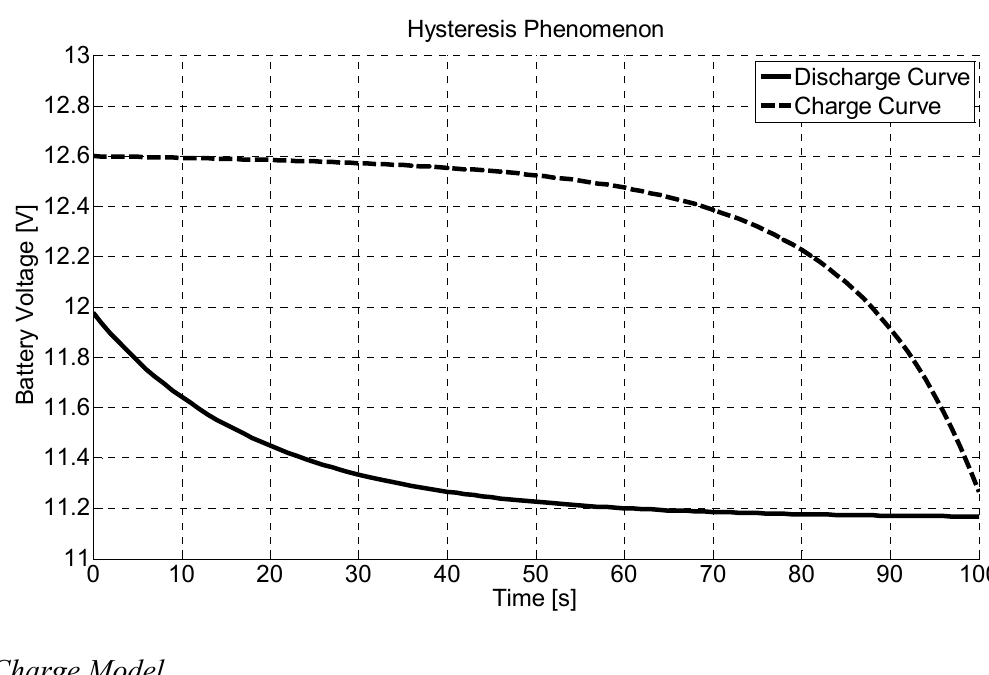
Figure 2. Hysteresis in exponential zone for a Lead-Acid